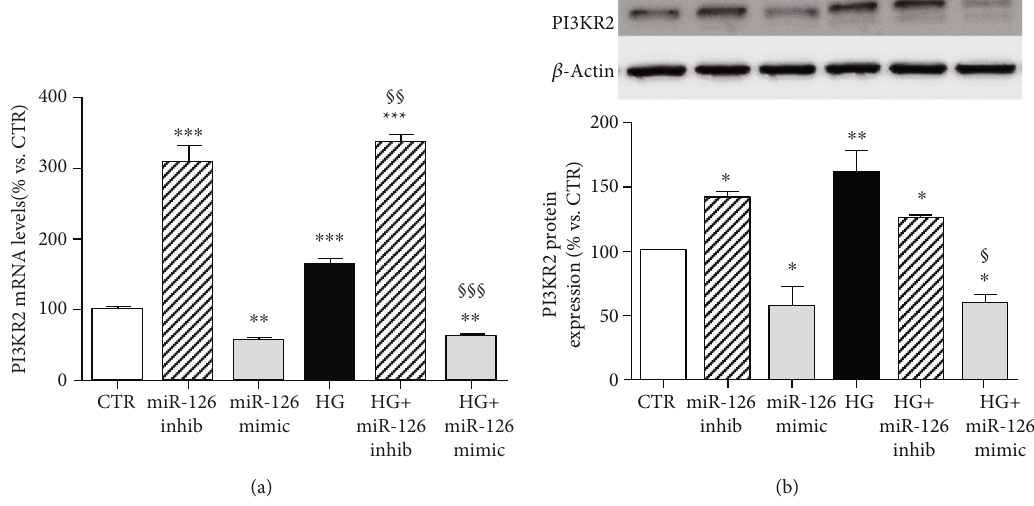
Figure 4: Expression of PIK3R2 in ARPE-19 cells cultured for 24 hours in standard medium (CTR), silencing (INHIB) and upregulating (MIMIC) miR-126 in control condition and in presence of high glucose (HG). (a) PIK3R2 gene expression normalized vs. β -actin as housekeeping gene. Representative Western blot analysis of (b) PIK3R2 protein expression with quanti fi cation of densitometries of relative bands. Data were expressed as mean ± SEM of fold induction relative to β -actin of three independent experiments ( n = 3 ). ∗ p < 0 : 05 , ∗∗ p < 0 : 01 , and ∗∗∗ p < 0 : 001 vs. CTR; § p < 0 : 05 , §§ p < 0 : 01 , and §§§ p < 0 : 001 HG+mimic vs.